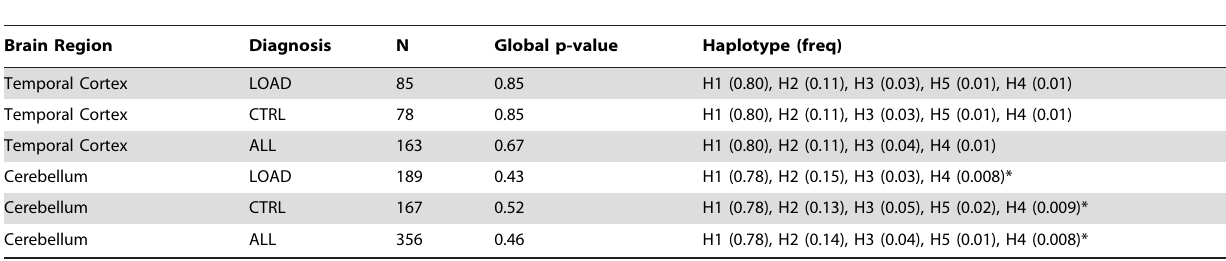
Table 7. GAB2 haplotypes are not associated with GAB2 mRNA expression in post-mortem brains.